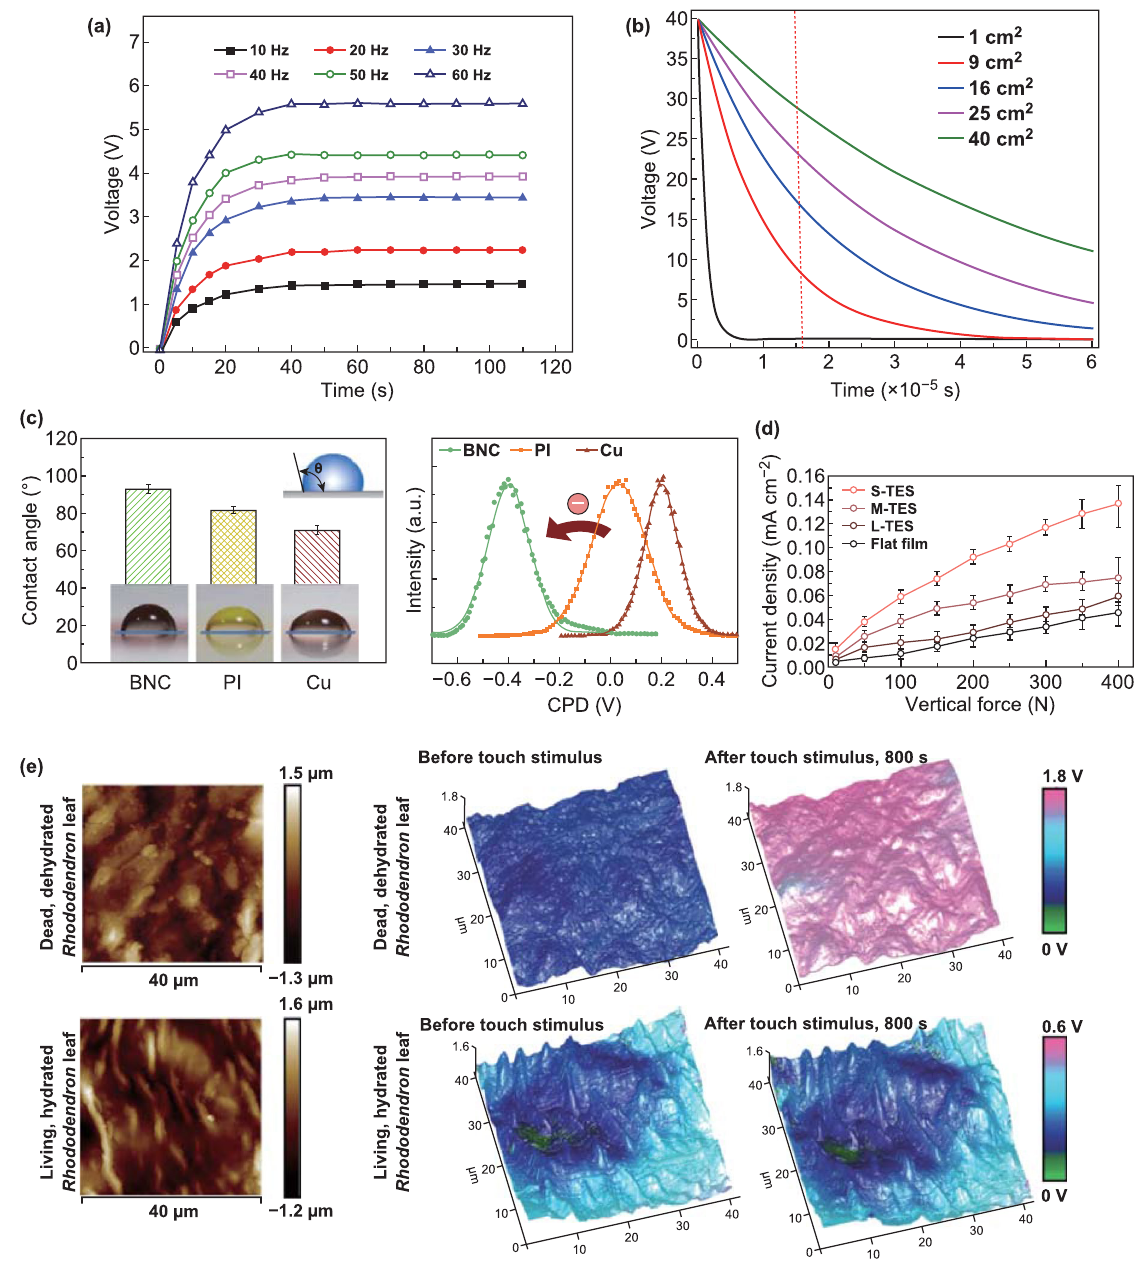
Fig. 5 Factors influencing the output performance of TENGs: a influence of the excitation frequency. b The output voltage as a function of the size contact area of TENGs. Reprinted with permission from Ref. [82]. Copyright (2016) Published by Elsevier Ltd. c Static water contact angle measurement and contact potential difference comparison of materials under friction. Reprinted with permission from Ref. [78] Copy‑ right (2017) Published by Elsevier Ltd. d Influence of the vertical force on output voltage. Reprinted with permission from Ref. [86]. Copyright (2016) Wiley‑VCH Verlag GmbH & Co. KGaA, Weinheim; e Kelvin probe force microscopy of the leaf before and after friction. Reprinted with permission from Ref. [61] Copyright (2018) Wiley‑VCH Verlag GmbH & Co. KGaA,